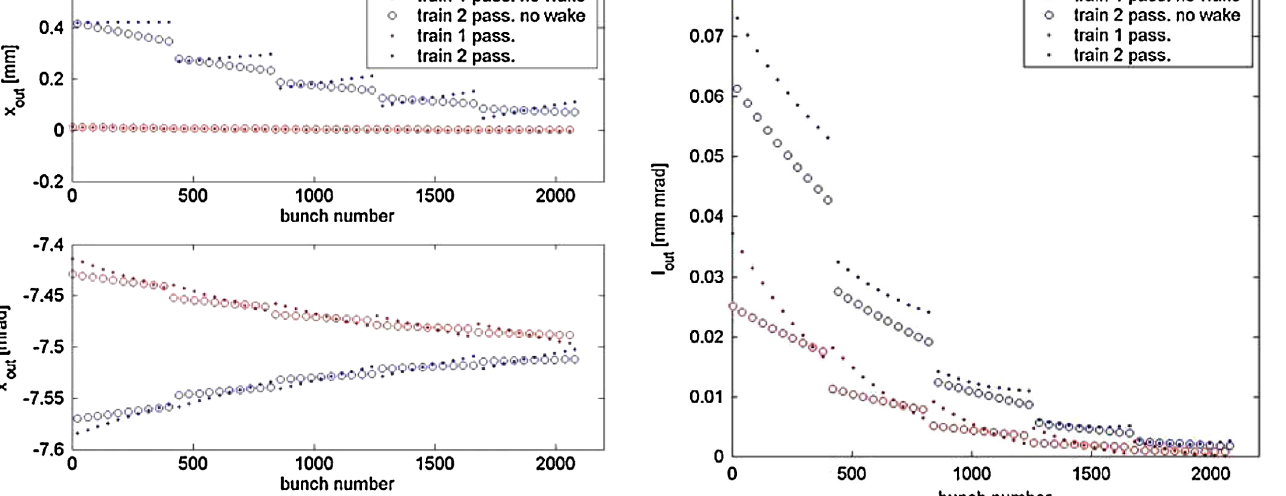
FIG. 15. (Color) Courant-Snyder invariants ( I out ) of the bunch centroids in the case of perfect